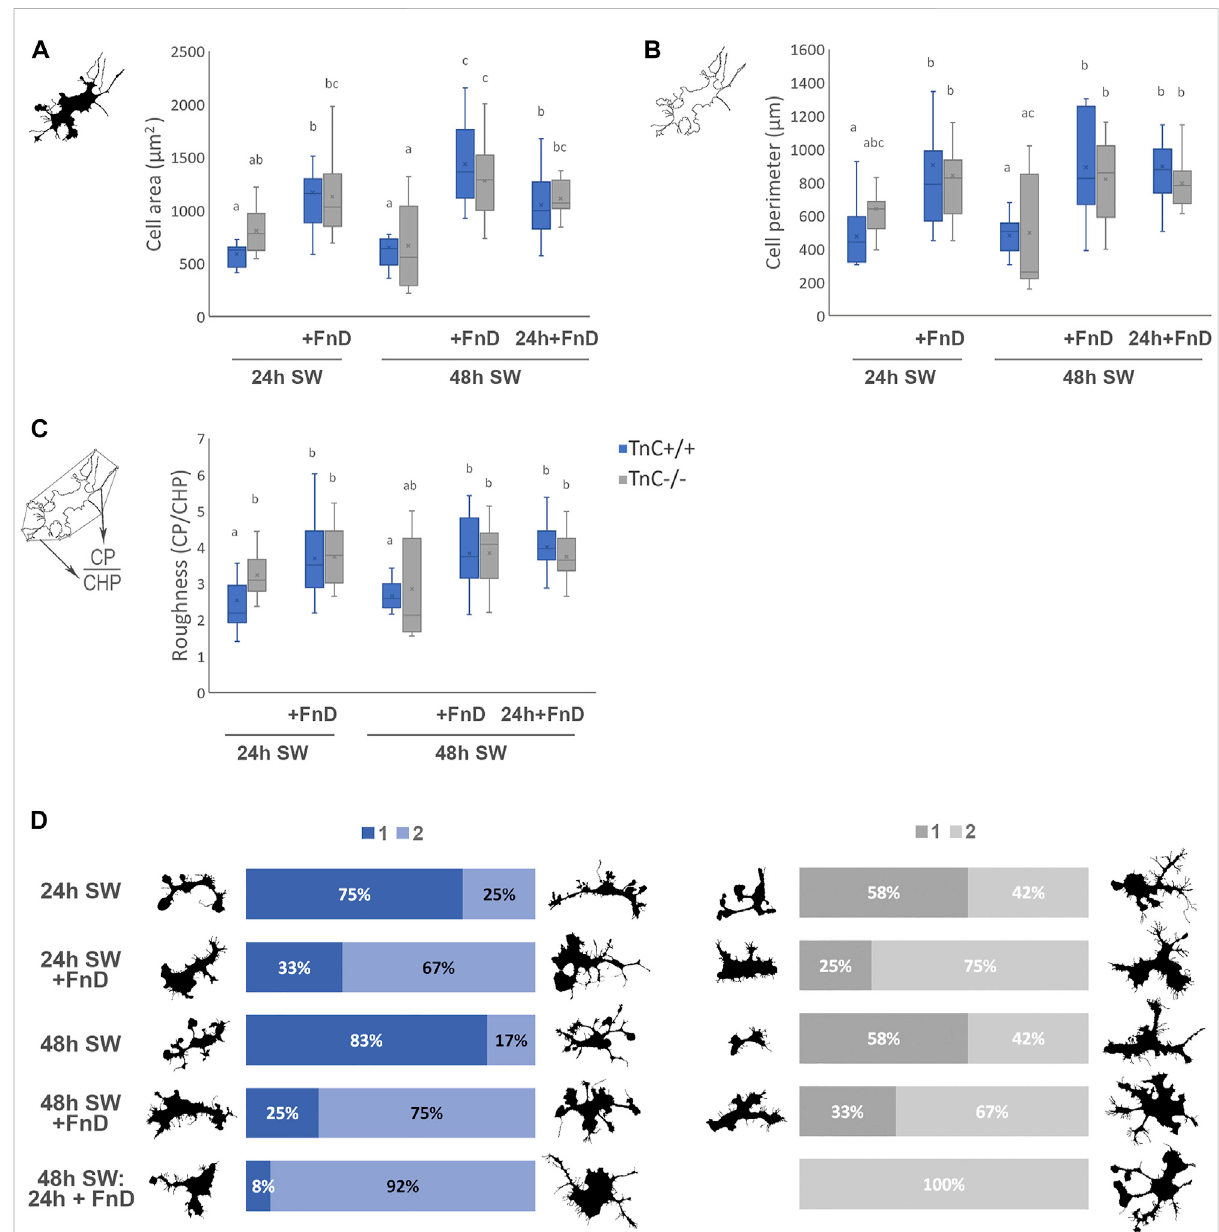
FIGURE 4 FnD treatment inducesactivated microglial morphology inthegaparea. Box — whiskerplots ofmicroglialcell area (A) cell perimeter (B) andcell roughness (C) are shown. Two-way ANOVA was used to test statistical signi fi cance. Pairwise comparisons are denoted with letters, shared letters imply no signi fi cant difference between groups. Actual p values are indicated in the text. Microglial cells were sorted into two clusters based on eleven measured morphological parameters per cell (main text Table 3). 100% stacked bar chart representing percentages of cluster membership per each group in respective genotype is shown including most representative cell shapes-cluster members with the smallest distance from the cluster centre (D) . Clusters were marked as 1 and 2 (D) (No. Microglial cells = 12, from three independent cultures, per treatment, per